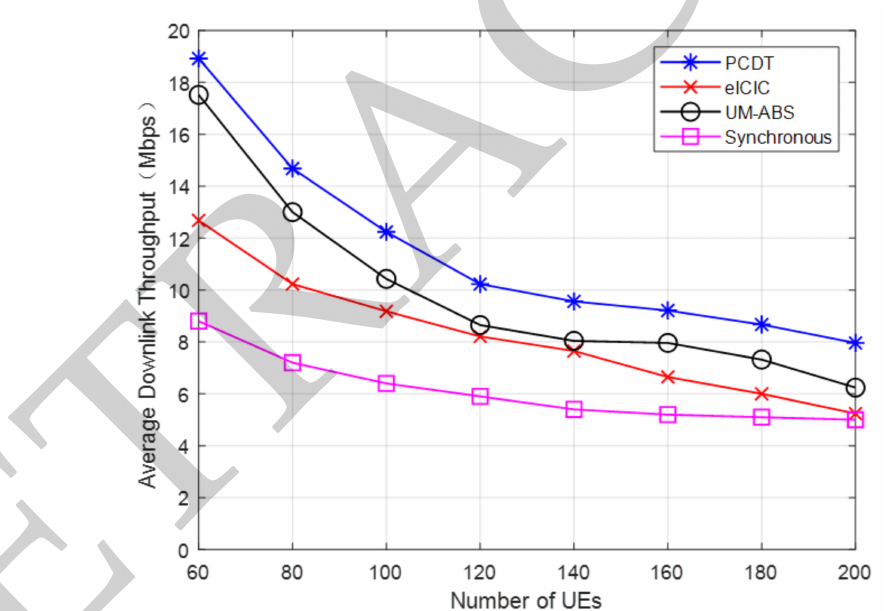
Figure 7. The comparison on the average downlink